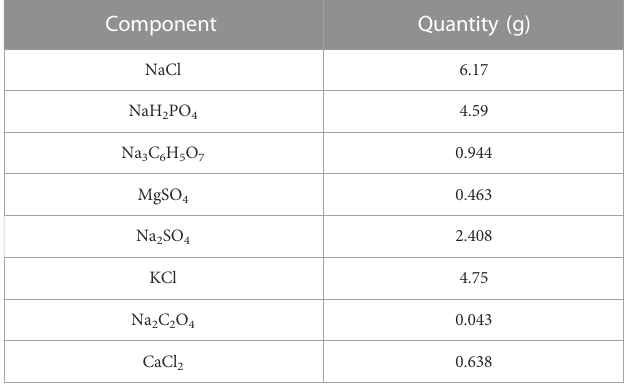
TABLE 1 Chemical components of the arti fi cial